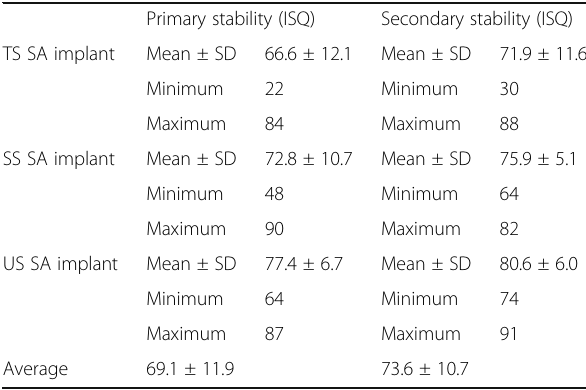
Table 3 Clinical findings of the installed